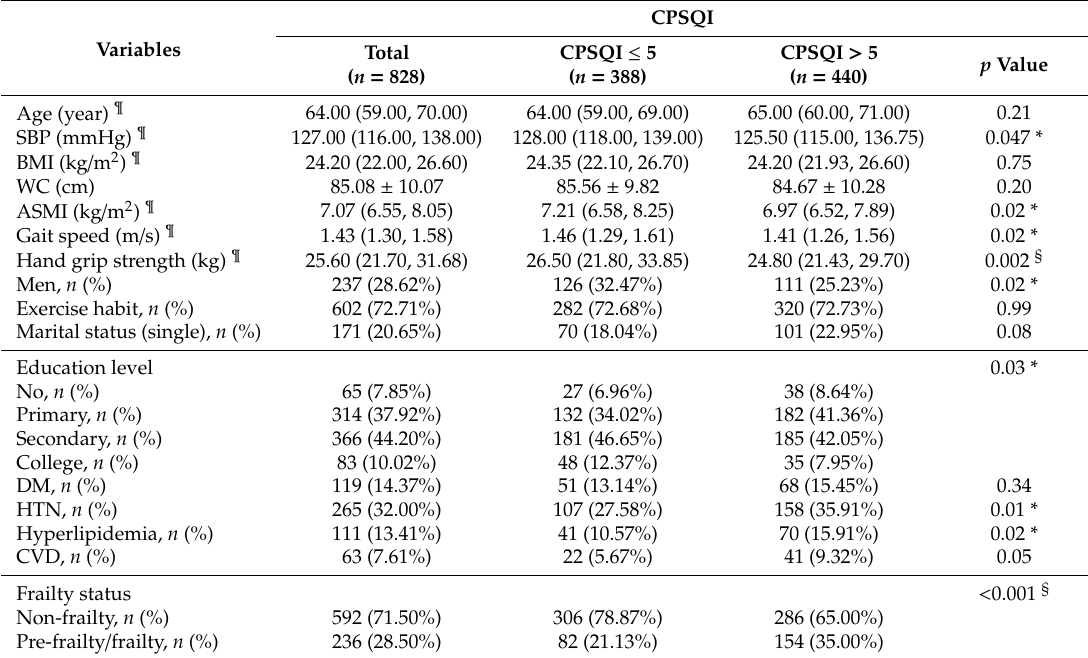
Table 1. General characteristics of the study population according to Chinese version of the Pittsburgh Sleep Quality Index (CPSQI)